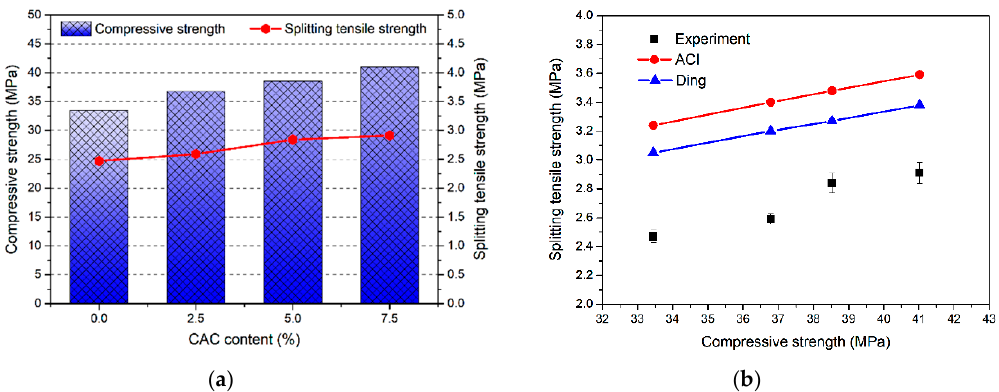
Figure 5. ( a ) Relationship between splitting tensile strength and compressive strength; ( b ) relationship of splitting tensile strength between experiment and proposed equations.